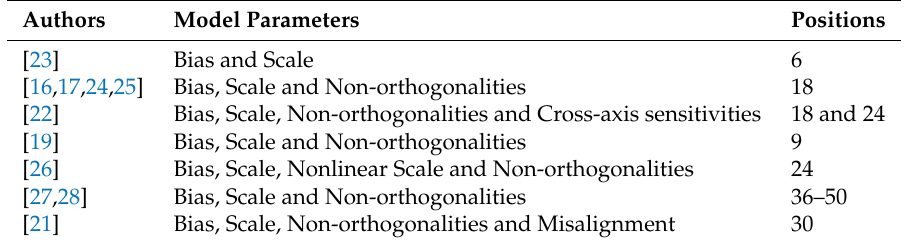
Related research of accelerometer triad error models, sorted by ascending date of first